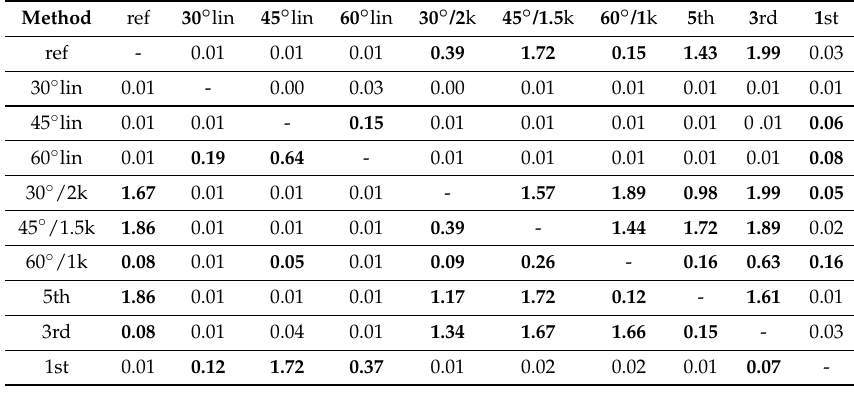
Table 4. p -values (Wilcoxon signed-rank test with Bonferroni–Holm correction) for ratings of continuity in Experiment II. The upper triangle corresponds to the pink noise, the lower triangle to music as source signal. Insignificant differences ( p -values ≥ 0.05) are indicated by bold